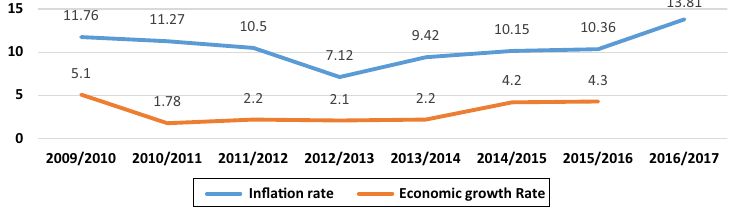
Figure 1. The in fl ation